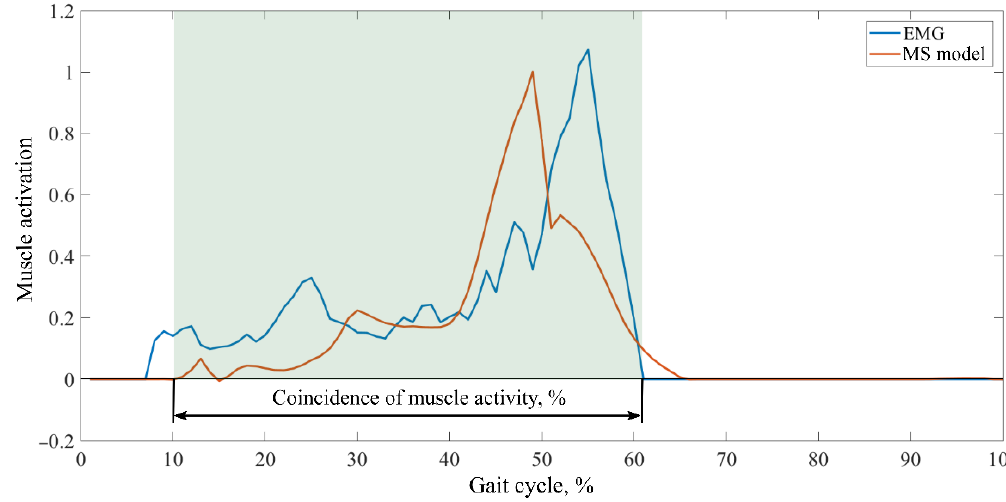
Figure 3. Assessment of the coincidence of the muscle activity